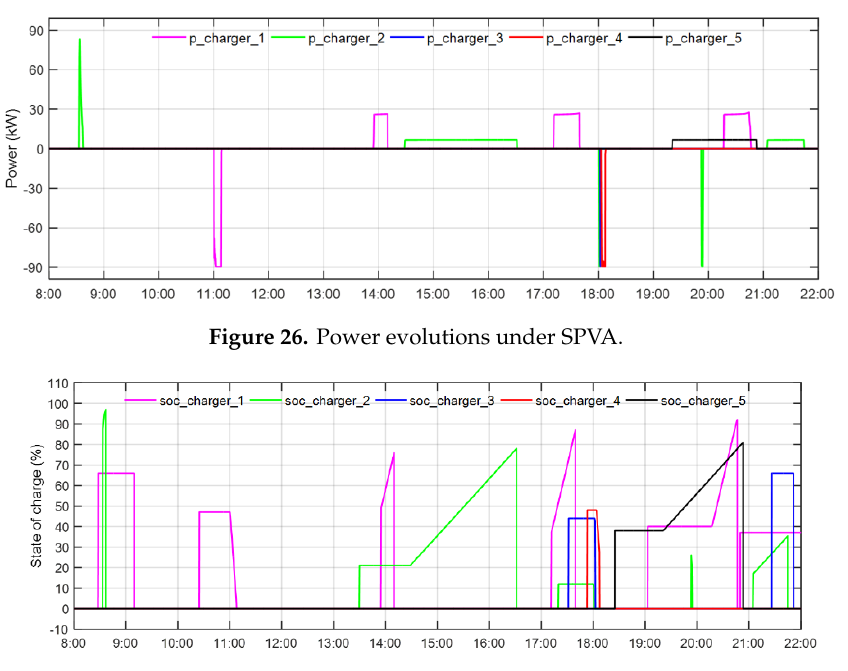
Figure 27. State of charge soc EV evolutions under SPVA. Figure 27. State of charge 𝑠𝑜𝑐 𝐸𝑉 evolutions under SPVA. Figure 27. State of charge 𝑠𝑜𝑐 𝐸𝑉 evolutions under SPVA. Figure 27. State of charge 𝑠𝑜𝑐 𝐸𝑉 evolutions under SPVA.